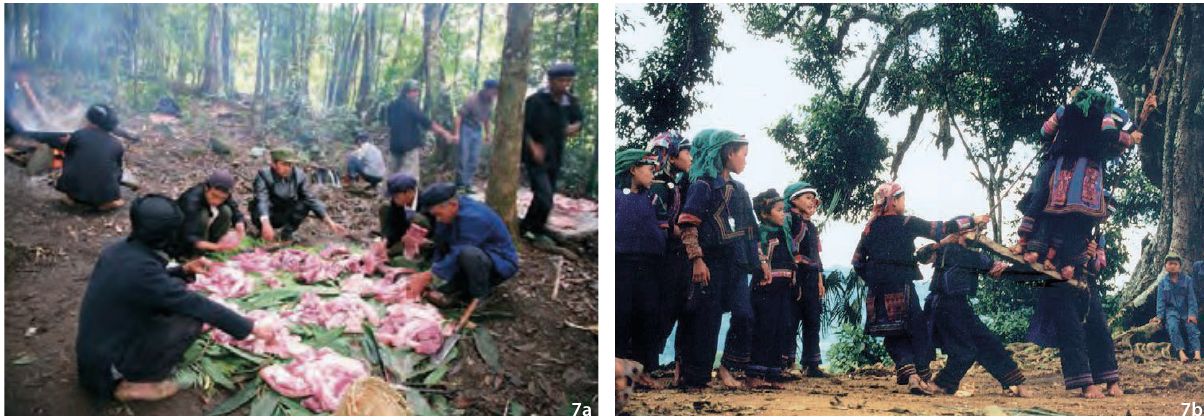
Figure 7a Zhai Shen Lin (the Second Month Festival) (Source: World Heritage Convention Cultural Heritage Nominated by People’s Republic of China, Cultural Landscape of Honghe Hani Rice Terraces). Figure 7b Postcard Reflecting Hani Culture (Play on the Swing) (Source: World Heritage Convention Cultural Heritage Nominated by People’s Re- public of China, Cultural Landscape of Honghe Hani Rice Terraces).